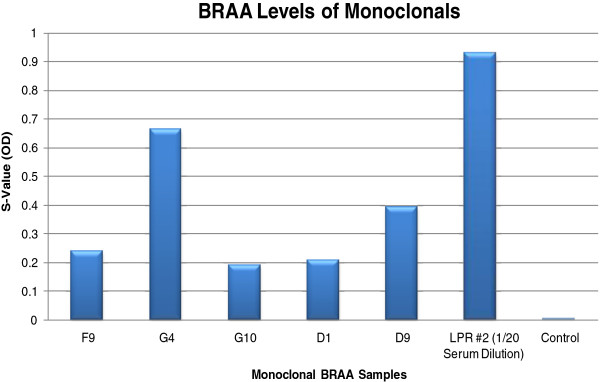
BRAA ELISA Results of our Potential Pathogenic Monoclonal BRAA. The graph showed the reactivity of the five potential clones (above 0.1 OD) and MRL/lpr#2. No binding was detected in the control.